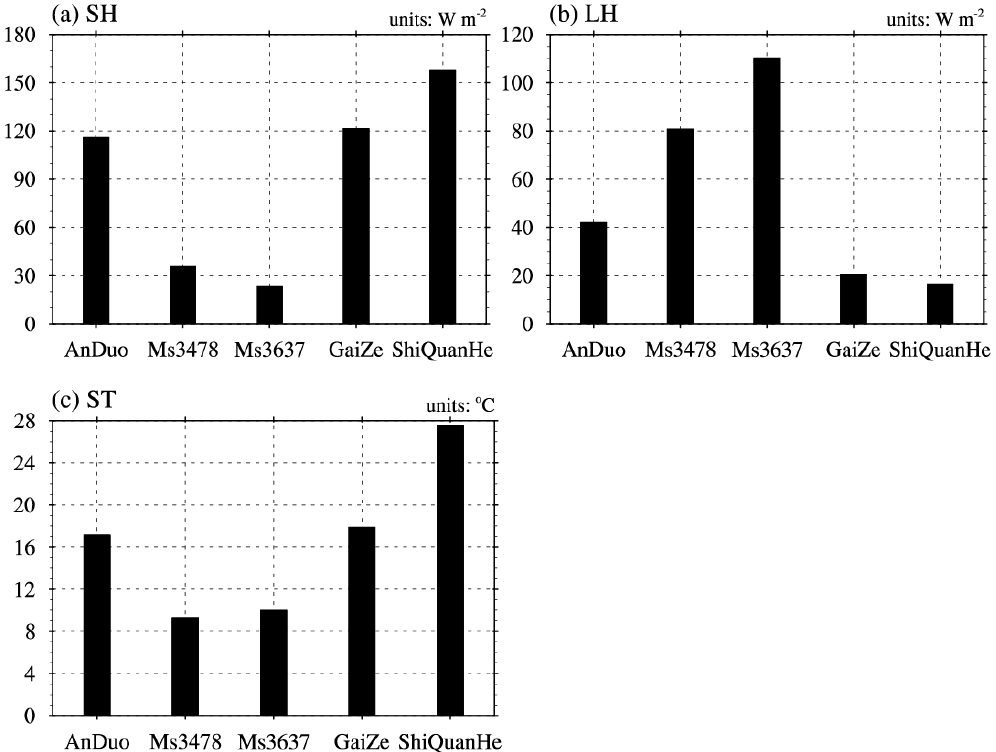
Figure 2. The simulated sensible heat flux (SH; a ), latent heat flux (LH; b ) and soil temperature (ST; c ) using the common land model (CoLM) with the unperturbed parameters at five Tibetan sites. For each site, SH, LH and ST are averaged in the corresponding study period, which was shown in Table 1.